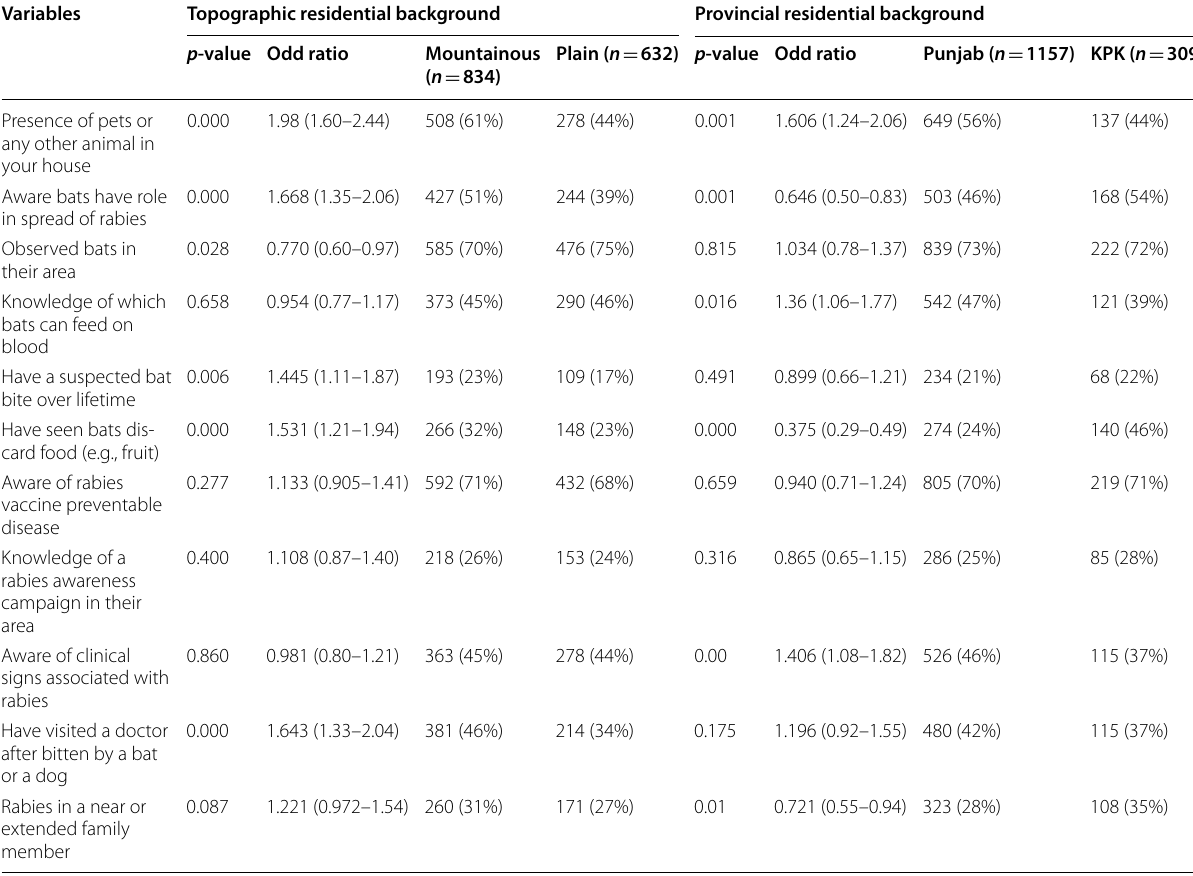
Table 2 Respondents’ responses in relation to their residential backgrounds, a cross-sectional survey on fruit bat-human interaction in Pakistan; one health perspective,